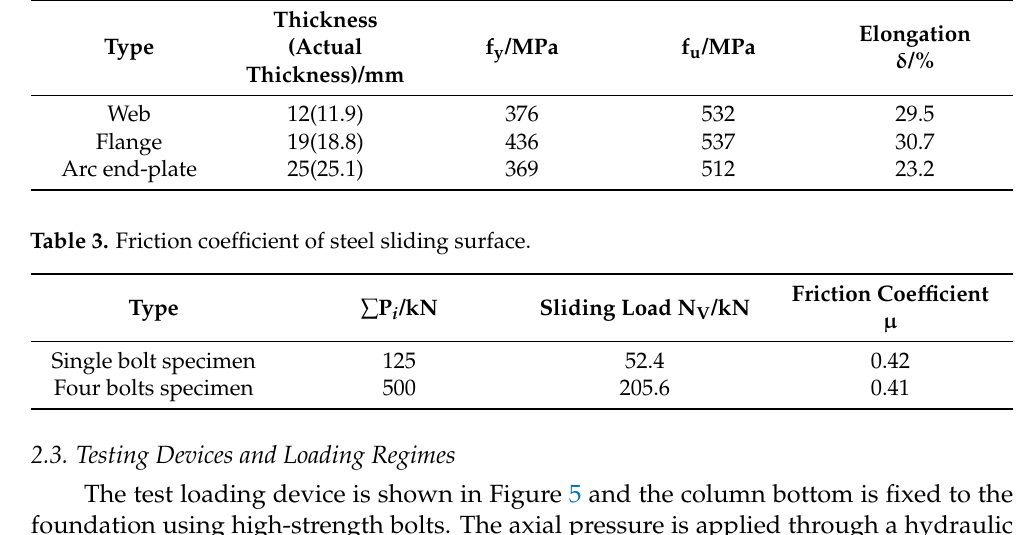
Table 2. Material properties.